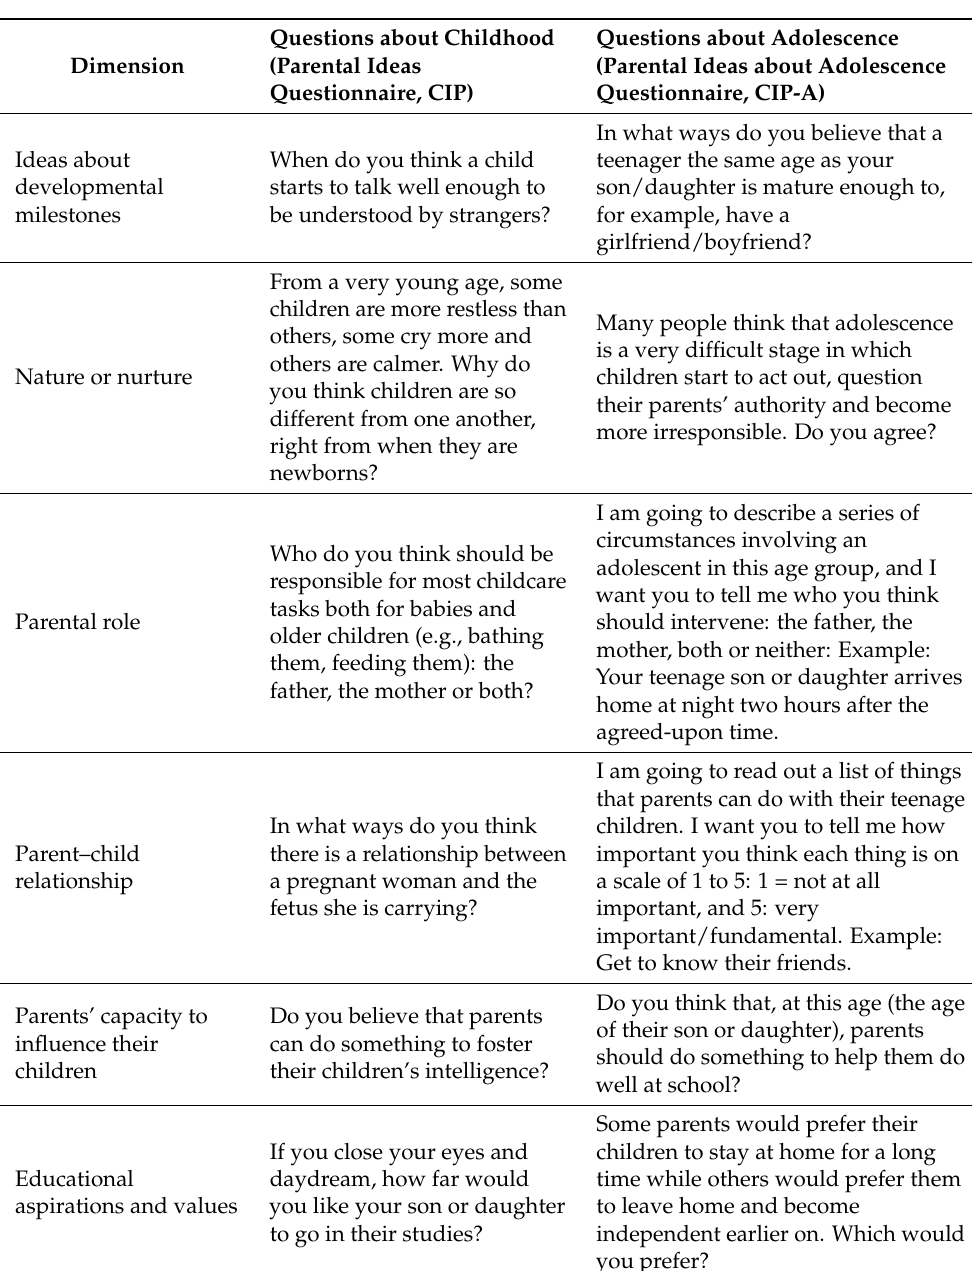
Table 1. Contents discussed in the interviews about parents’ ideas regarding child-rearing and development during childhood and